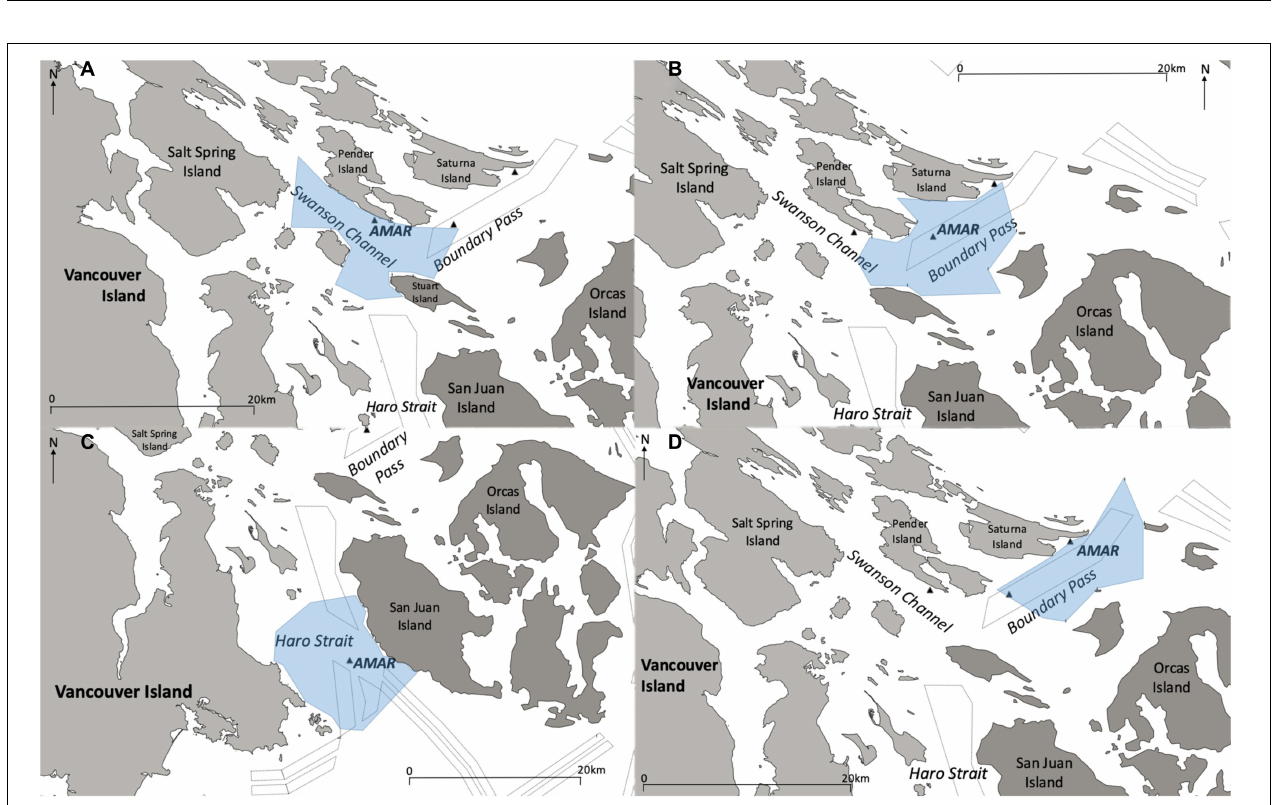
FIGURE 5 | Modified polygons of maximum extent of 8 km (blue shading) around the (A) Swanson Channel, (B) Boundary Pass, (C) Haro Strait, and (D) East Point, Saturna Island acoustic moorings (labeled AMAR) used to quantify vessel passages.